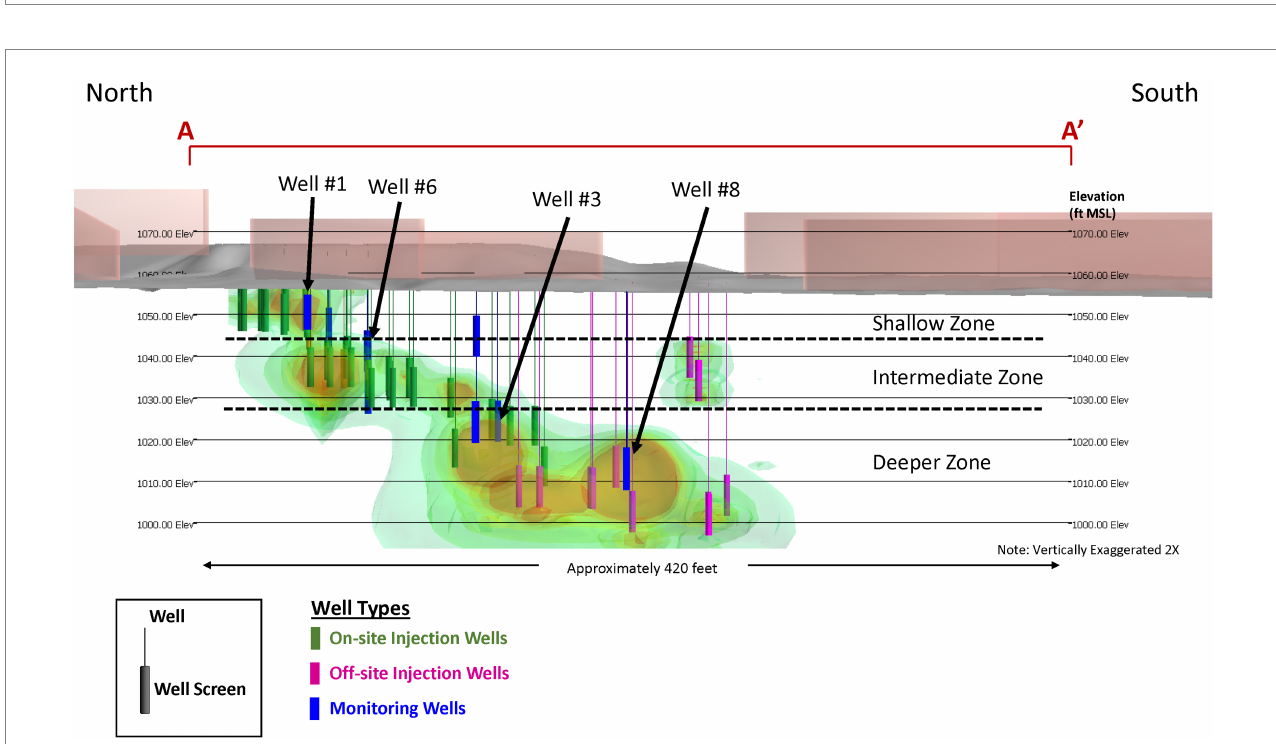
FIGURE 4 Site 1 cross-sectional view of full-scale implementation of the enhanced bioremediation